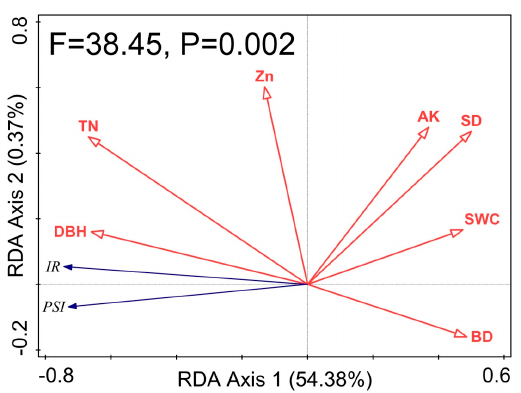
Figure 1. First two canonical axes of redundancy analysis (RDA) ordination biplot between the occurrence of web-spinning sawflies and significant environmental variables. SD, stem density; TN, total nitrogen; AK, available potassium; SWC, soil water content; DBH, diameter at breast height; BD, bulk density; Zn, Zinc ion; IR, infestation ratio; PSI, pest severity index. Table 6. Forward selection of seven significant environmental variables by Monte Carlo permutation test in RDA.